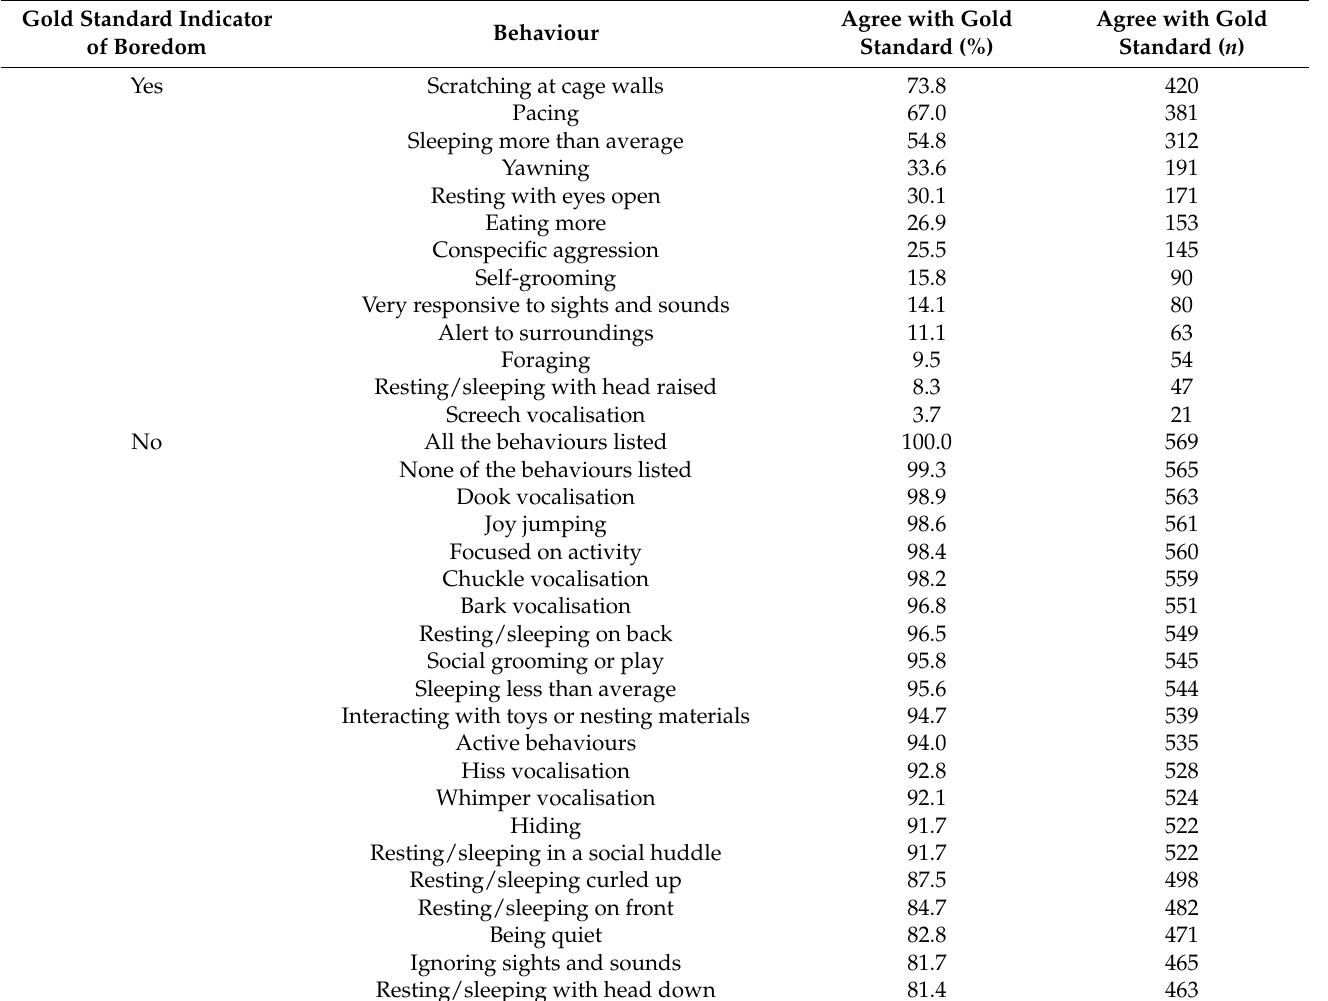
Table 4. The behaviours offered to respondents to select from as occurring in a bored ferret or not. Results are listed in order by % of respondents agreeing with the gold standard (Yes/No) status of the behaviour as an indicator of boredom. For gold standard behaviours that indicate boredom (Yes), the % represents respondents who selected the behaviour as being a boredom indicator. For behaviours that are not gold standard boredom indicators (No), the % represents respondents who did not select the behaviour as being an indicator of boredom. Behaviours are shown in bold font where over 50% of the respondents agreed with the gold standard. The total number of respondents answering this question was